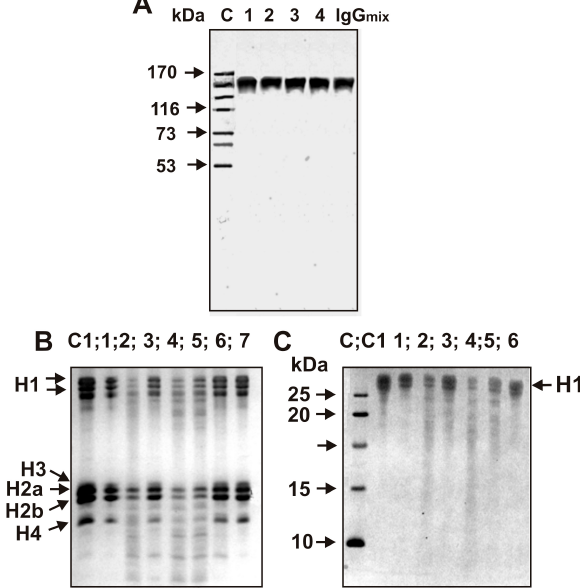
Figure 1. ( A ) SDS-PAGE analysis of homogeneity of four individual IgGs and IgG mix (9 µ g) from the sera of MS patients in a nonreducing 3–16% gradient gel (lanes 1–4 and IgG mix ) followed by silver staining The arrows (lane C) indicate the positions of protein molecular mass markers; ( B ) SDS-PAGE analysis of the activity of several di ff erent IgGs in the hydrolysis of H1, H2a, H2b, H3, and H4 histones resulting in the formation of their fragments. The reaction mixtures was incubated for 20 h at 37 ◦ C with 0.05 mg / mL IgGs (lanes: 1—RMS3, 2—debut of multiple sclerosis (DMS6), 3—secondary progressive multiple sclerosis (SPMS)1, 4—DMS7, 5—DMS8, 6—SPMS2, 7—RMS4); ( C ) Hydrolysis of recombinant H1 histone by several di ff erent IgGs leading to the formation of their fragments; lanes: